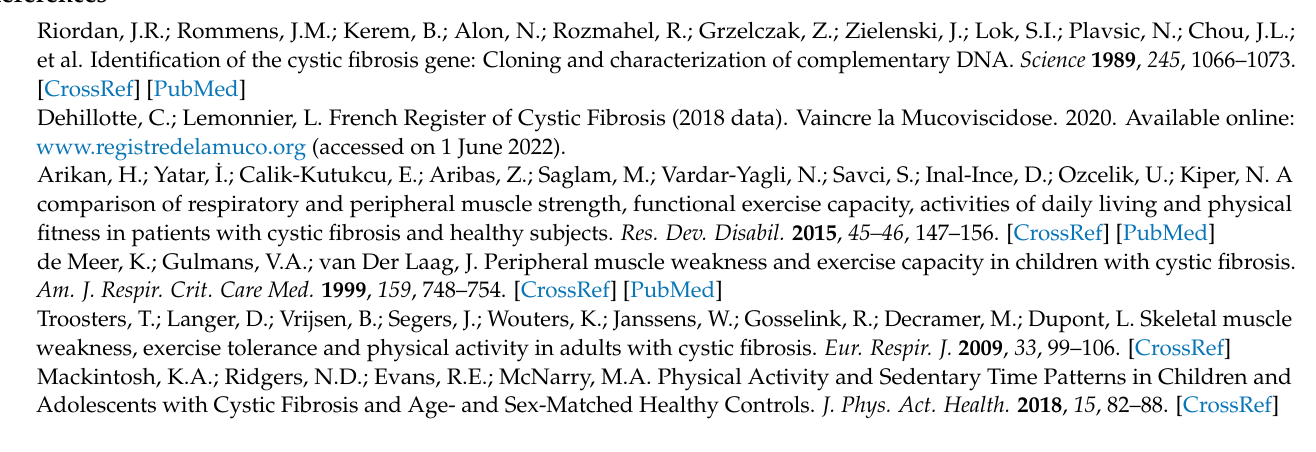
Table S1. Full text studies rejected with reasons. File S3. Funnel plots and Egger’s bias statistics regression; Figure S1. Lower limb muscle strength, Figure S2. Upper limb muscle strength, Figure S3. Muscle mass, Figure S4. VO 2 peak, Figure S5. Physical activity level. File S4. Table S2. Detailed exercise training interventions. File S5. Table S3. Detailed methods for muscle strength measurement. File S6. Summary of the risk of bias for the primary outcome; Figure S6. Lower limb muscle strength, Figure S7. Upper limb muscle strength. File S7. Forest plot of comparison and risk of bias for the secondary outcomes; Figure S8. Muscle mass, Figure S9. VO 2 peak, Figure S10. Physical activity